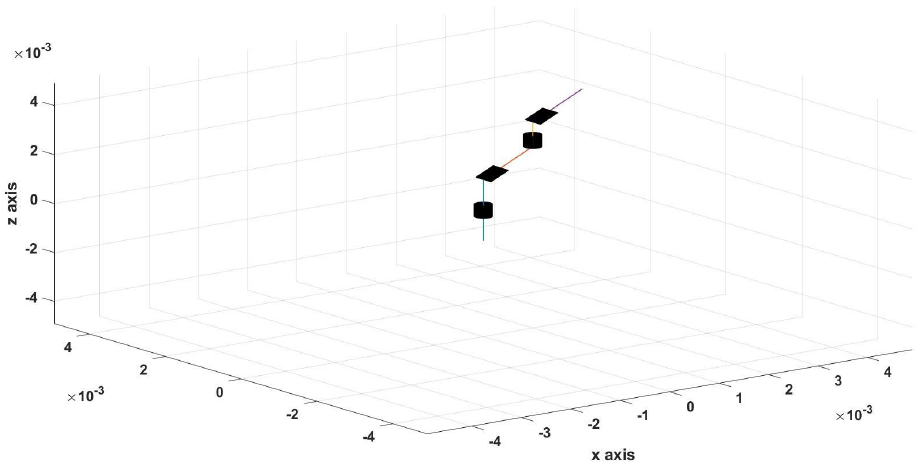
Figure 15. Orientation of an MNR in